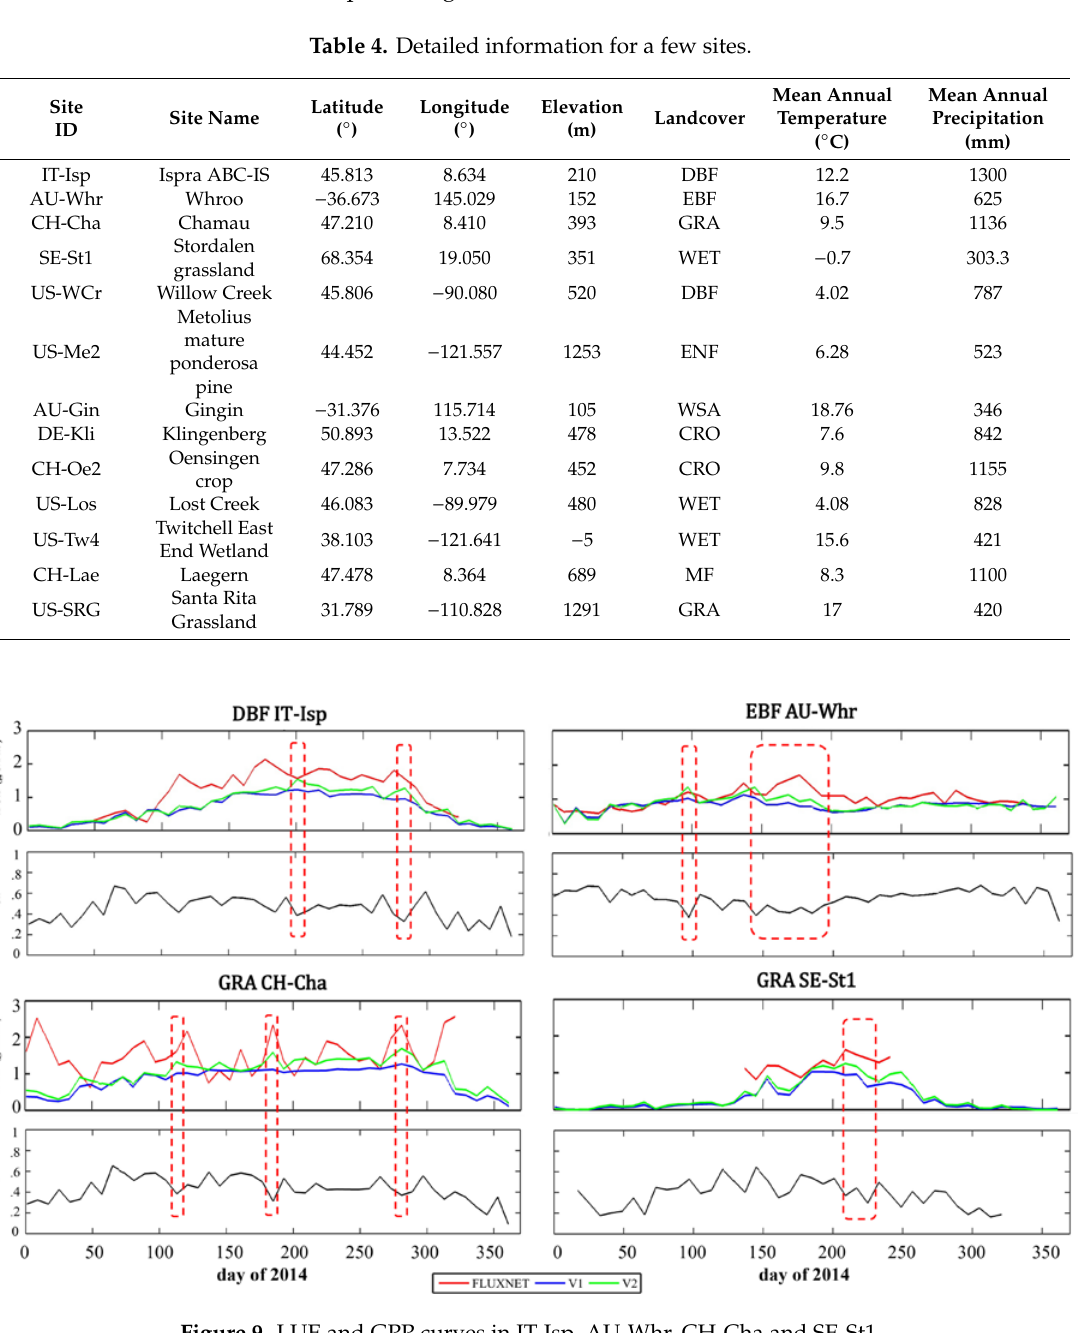
Figure 10. Global GPP in each type of vegetation. V1: Parameterization approach without the CI; V2: 505